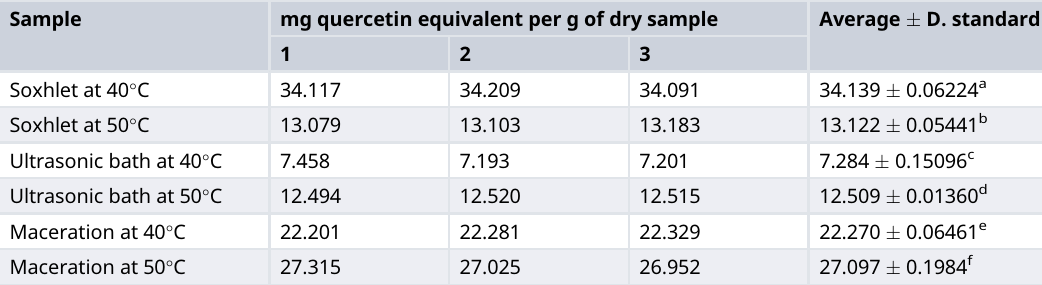
Table 8. Total flavonoid content corresponding to quercetin equivalents.